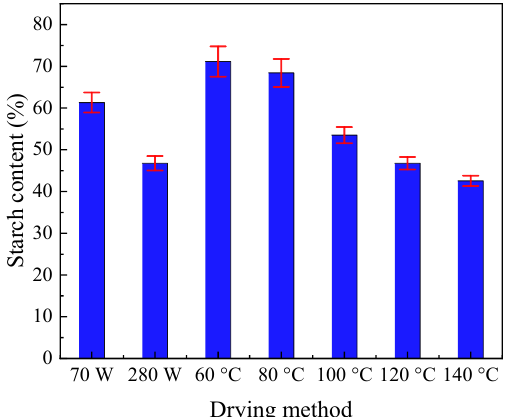
Figure 10. Comparison of crack rates in different drying methods.